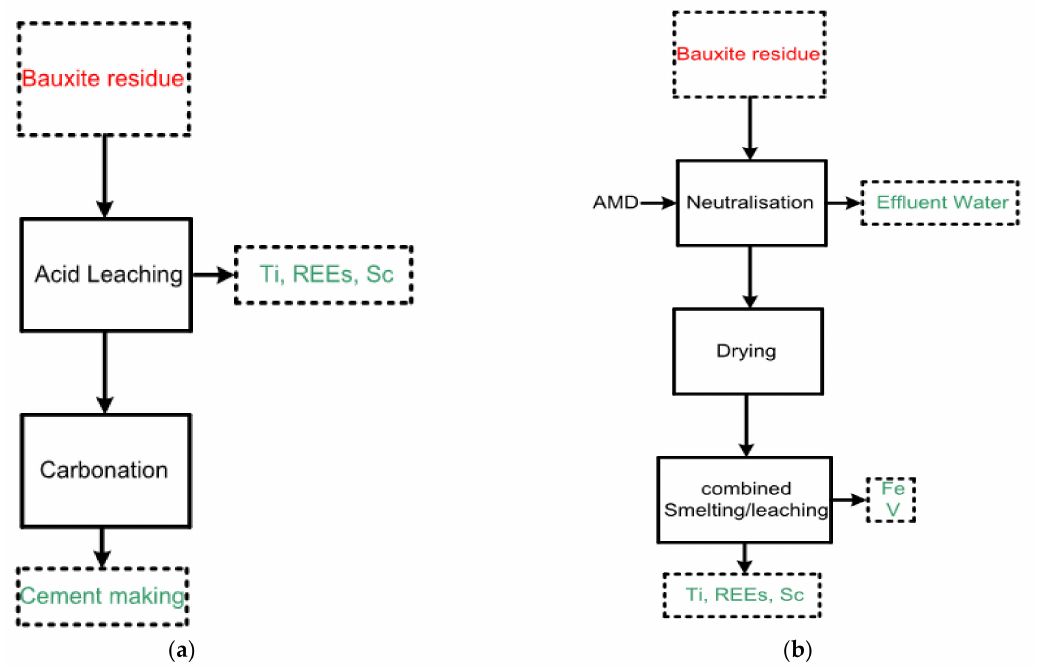
Figure 12. A zero-waste valorization vision for bauxite residue through experimental results: ( a ) for cement industry (left), and ( b ) treatment of AMD solution and recovery of Fe, V, Ti, REE, and Sc